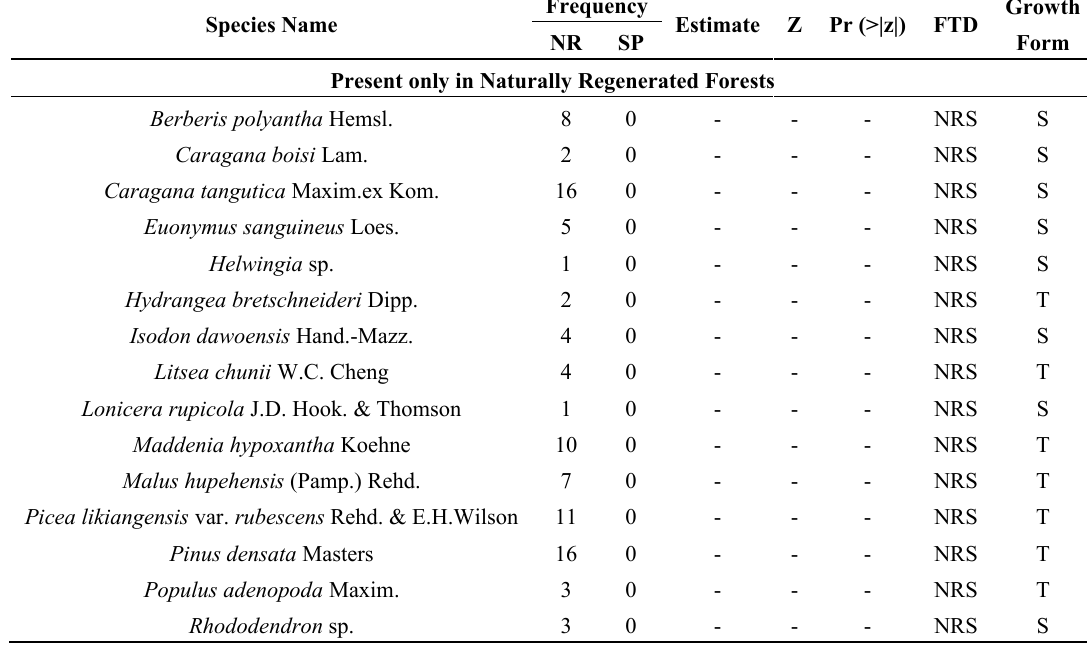
Table A2. Woody plant species composition of the naturally regenerated forests (NR) and the artificial reforested spruce plantation (SP) originating from similar clear-cuts in the eastern Tibetan Plateau. The difference of frequency between the NR and the SP was tested by generalized linear mixed-effects models (GLMMs). Treatment (NR vs. SP) was introduced as fixed factor and stands (12 vs. 12) as random factor, three plots nested in each stand, and nine quadrats nested in each plot. In each case, binomial error distribution with logit-ling function for presence (1) and absence (0) was selected in GLMMs. Frequency tendency distribution (FTD): natural regeneration species (NRS), species only present or more frequent in naturally regeneration forests relative to reforested spruce plantations; reforestation species (RES), species only or more frequent in reforested spruce species relative to natural stands; GES, generalist